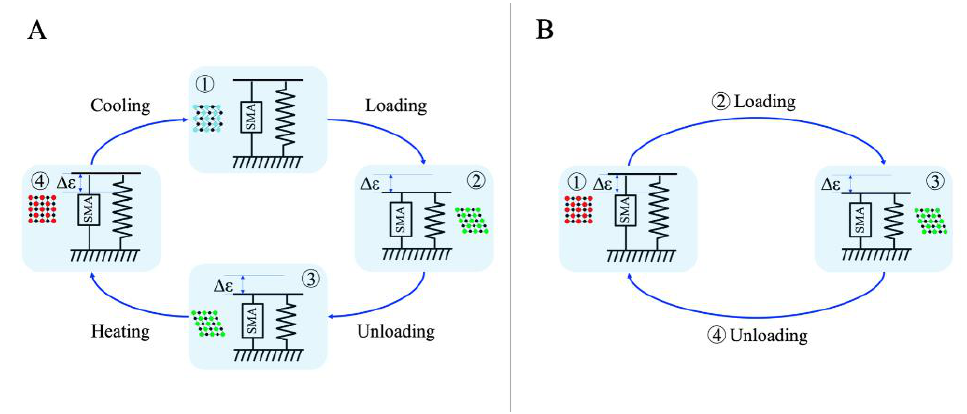
Figure 1. Deformation cycle of shape memory alloys. ( A ) SMA-ME; ( B ) SMA-SE.